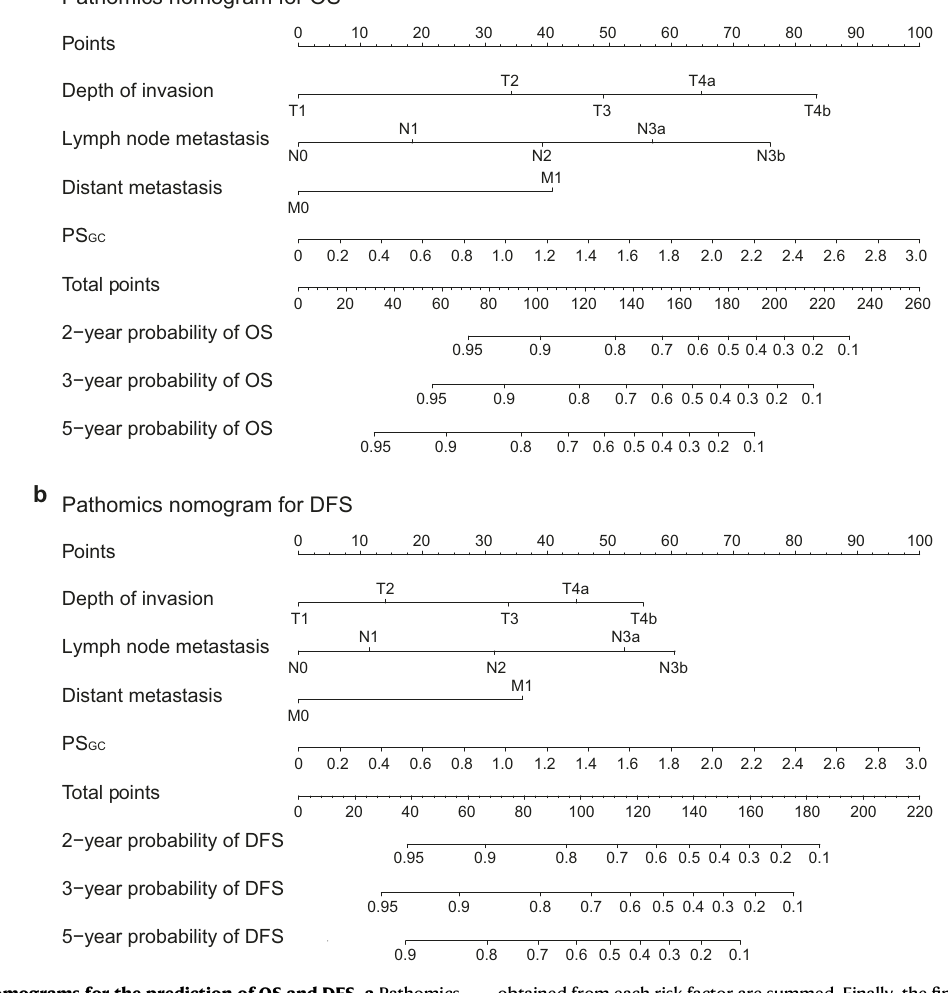
obtained from each risk factor are summed. Finally, the fi nal sum is located on the Total point axis. A line is drawn straight down to fi nd the patient ’ s probability of survival.OSoverallsurvival,DFSdisease-freesurvival, PS GC pathomicssignatureof gastric cancer. Source data are provided as a Source data fi